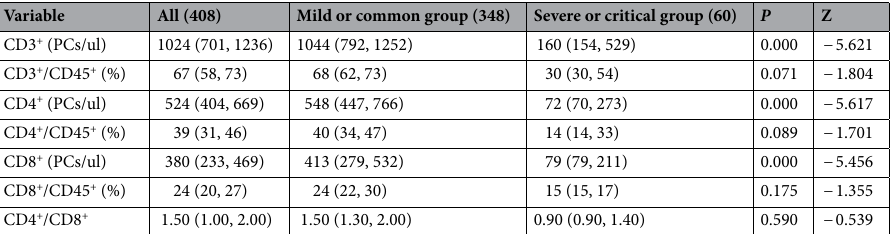
Table 3. The feature of T-lymphocyte subsets in mild or common group and severe or critical group in training set.